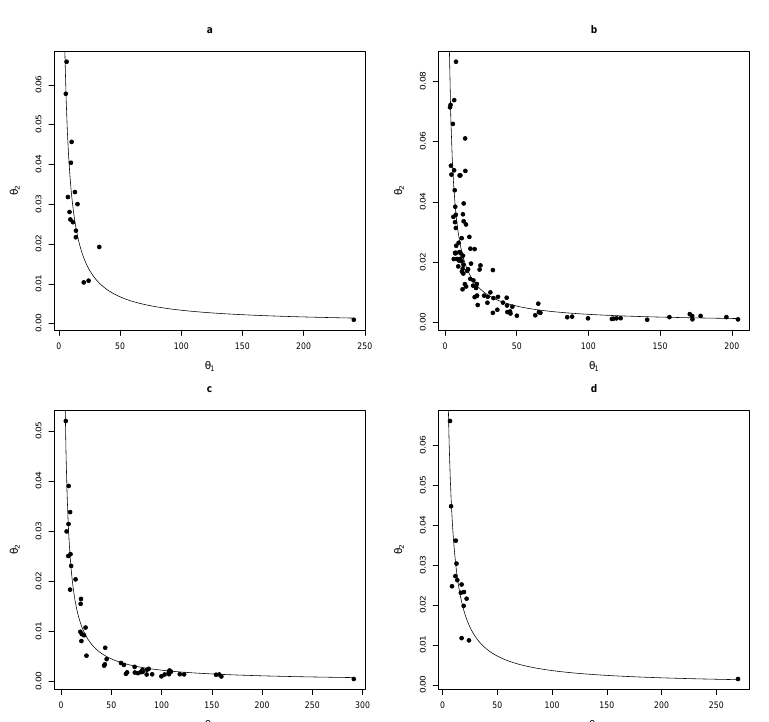
Figure 3. Chapman-Richards BAS model parameters relationship θ 2 = a / θ 1 for the species: ( a ) Pinus arizonica ( a = 0.34, p < 0.001), ( b ) Pinus engelmannii ( a = 0.27, p < 0.001), ( c ) Pinus strobiformis ( a = 0.23, p < 0.001) and ( d ) Pinus teocote ( a = 0.30, p < 0.001).